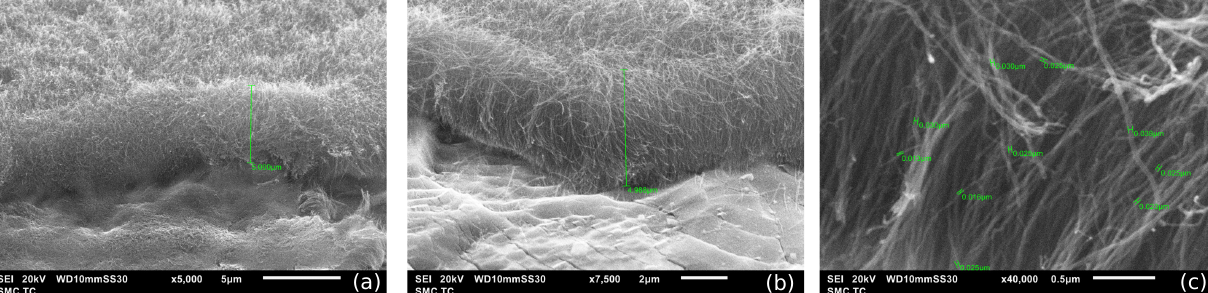
Figure 1. SEM images of a grown MWCNT array on a titanium plate used by us for preparation of PANI/VA-MWCNT pseudocapacitor. Scale bar: 5 µ m ( a ), 2 µ m ( b ) and 0.5 µ m ( c